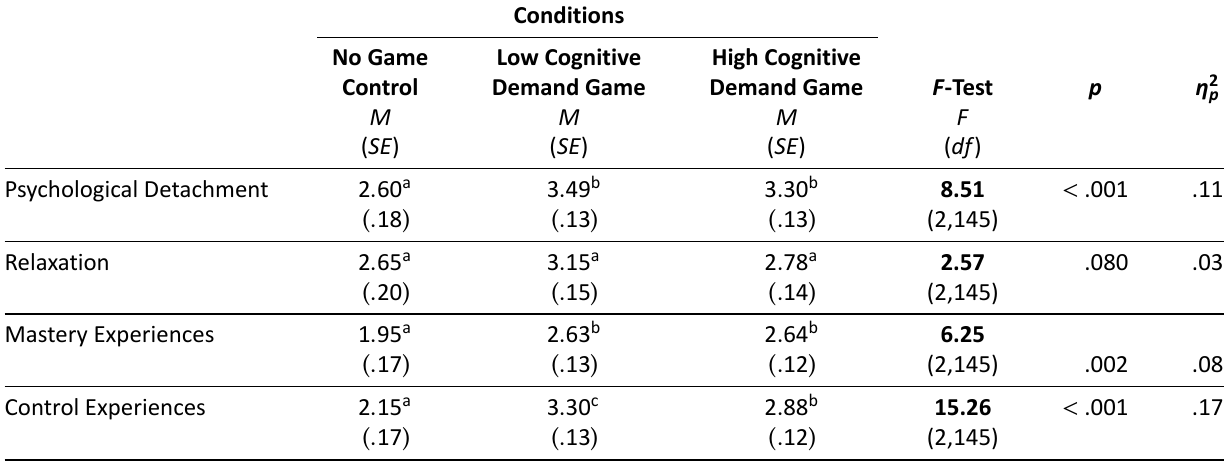
Table 1. Univariate analyses and simple comparisons between conditions for all recovery